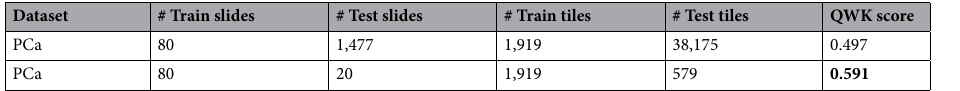
Table 6. Performance comparison of the model trained on a subset of the PCa dataset, when evaluated on test sets with different sizes. Bold value indicates best results